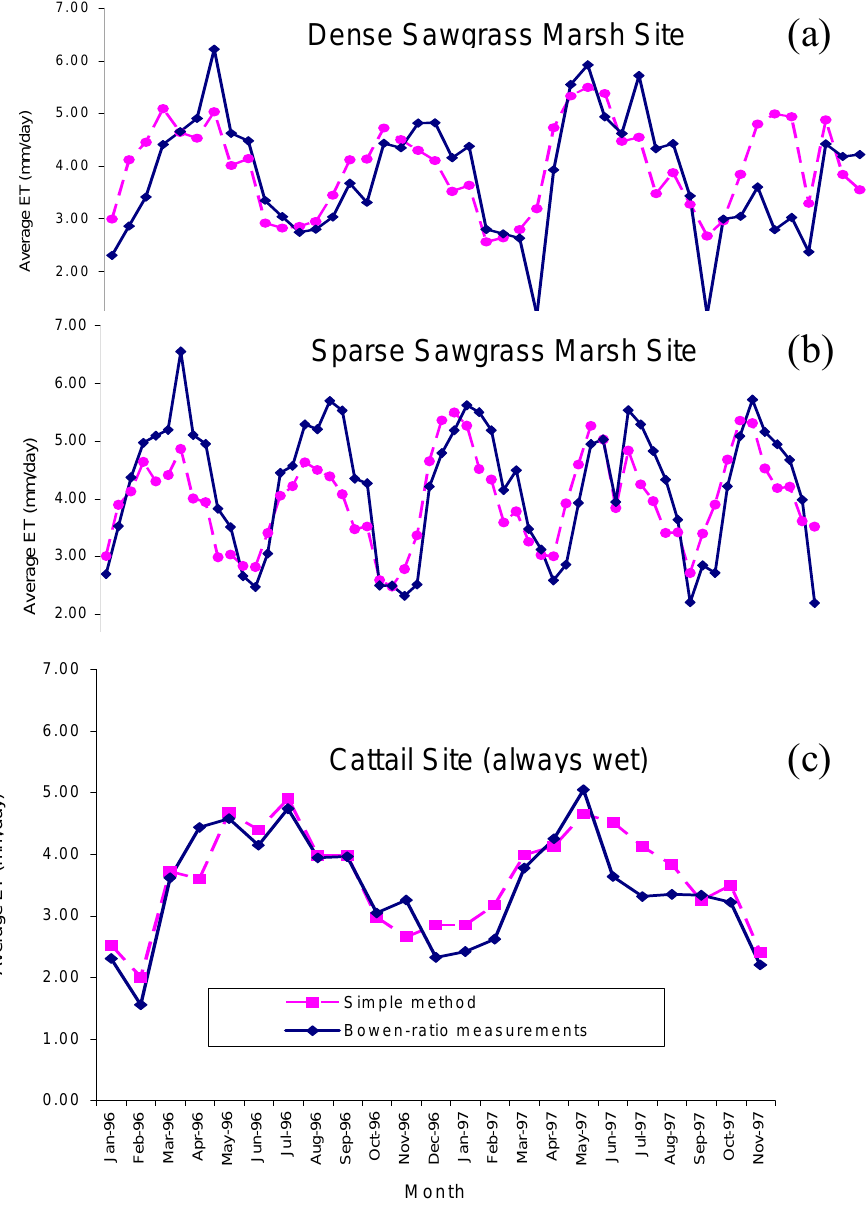
Figure 2. Comparison of the Simple (Abtew) Method ET with Bowen ratio measurements for south Florida wetland system: covers (a) dense sawgrass marsh, (b) sparse sawgrass marsh, and (c)